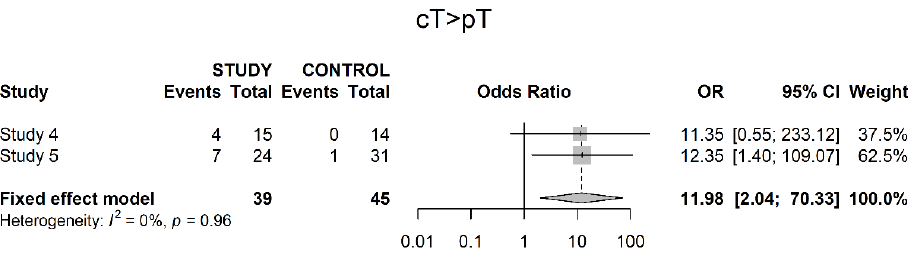
Figure 7. Downstaging from clinical to pathological T stage.